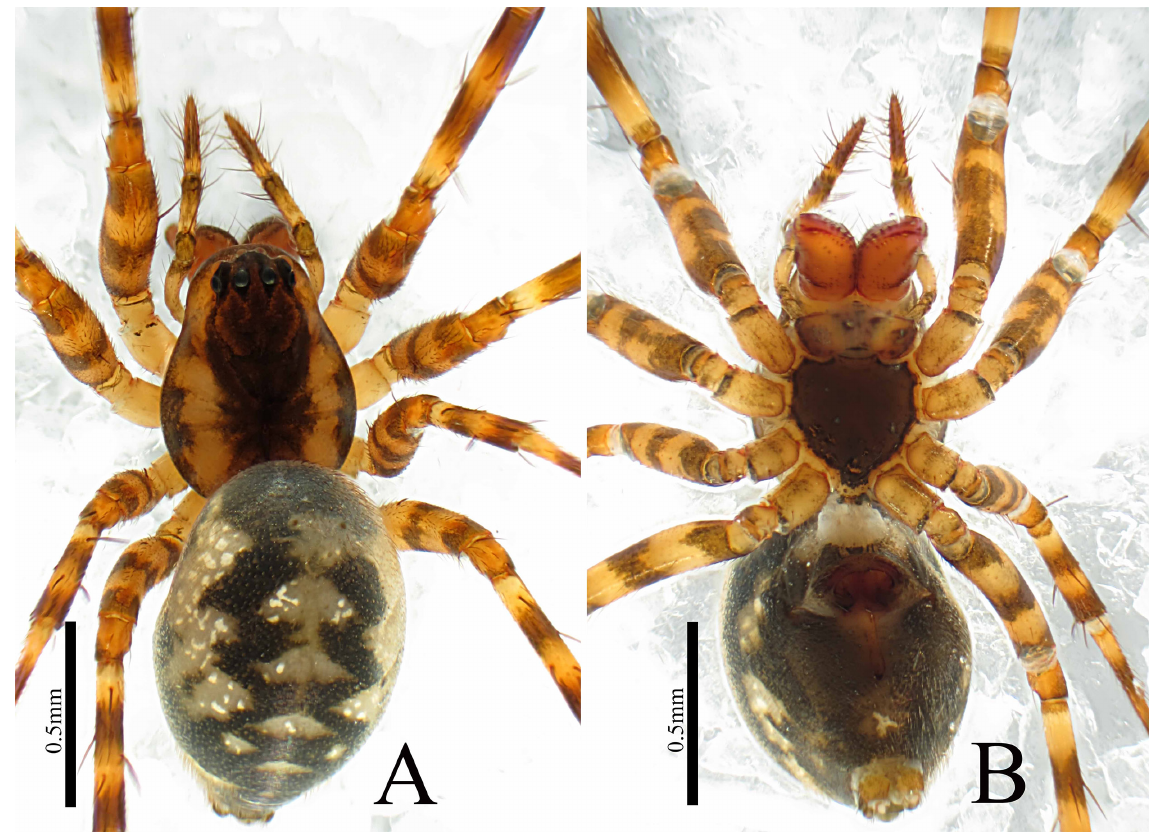
Fig. 20. Acroterius hamatus gen. et sp. nov., ♀, holotype (HNU-Tang–04–04). A . Habitus, dorsal view. B . Habitus, ventral